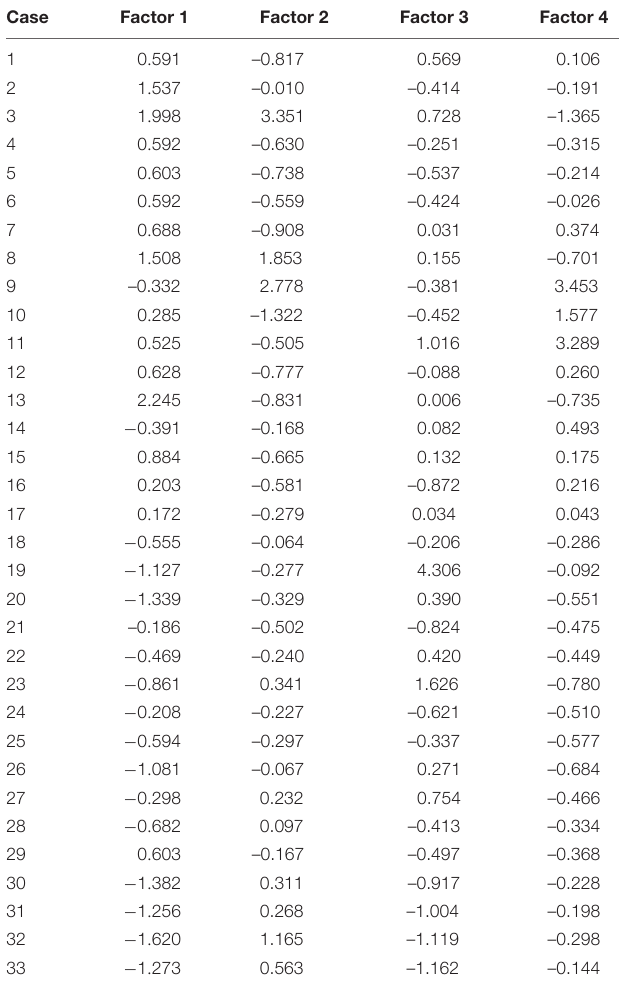
TABLE 3 | Factor scores extracted from the multivariate analysis (PCA) relative to the selected group of thirty-three sites (see Appendix 1 for explanation of cases). Case Factor 1 Factor